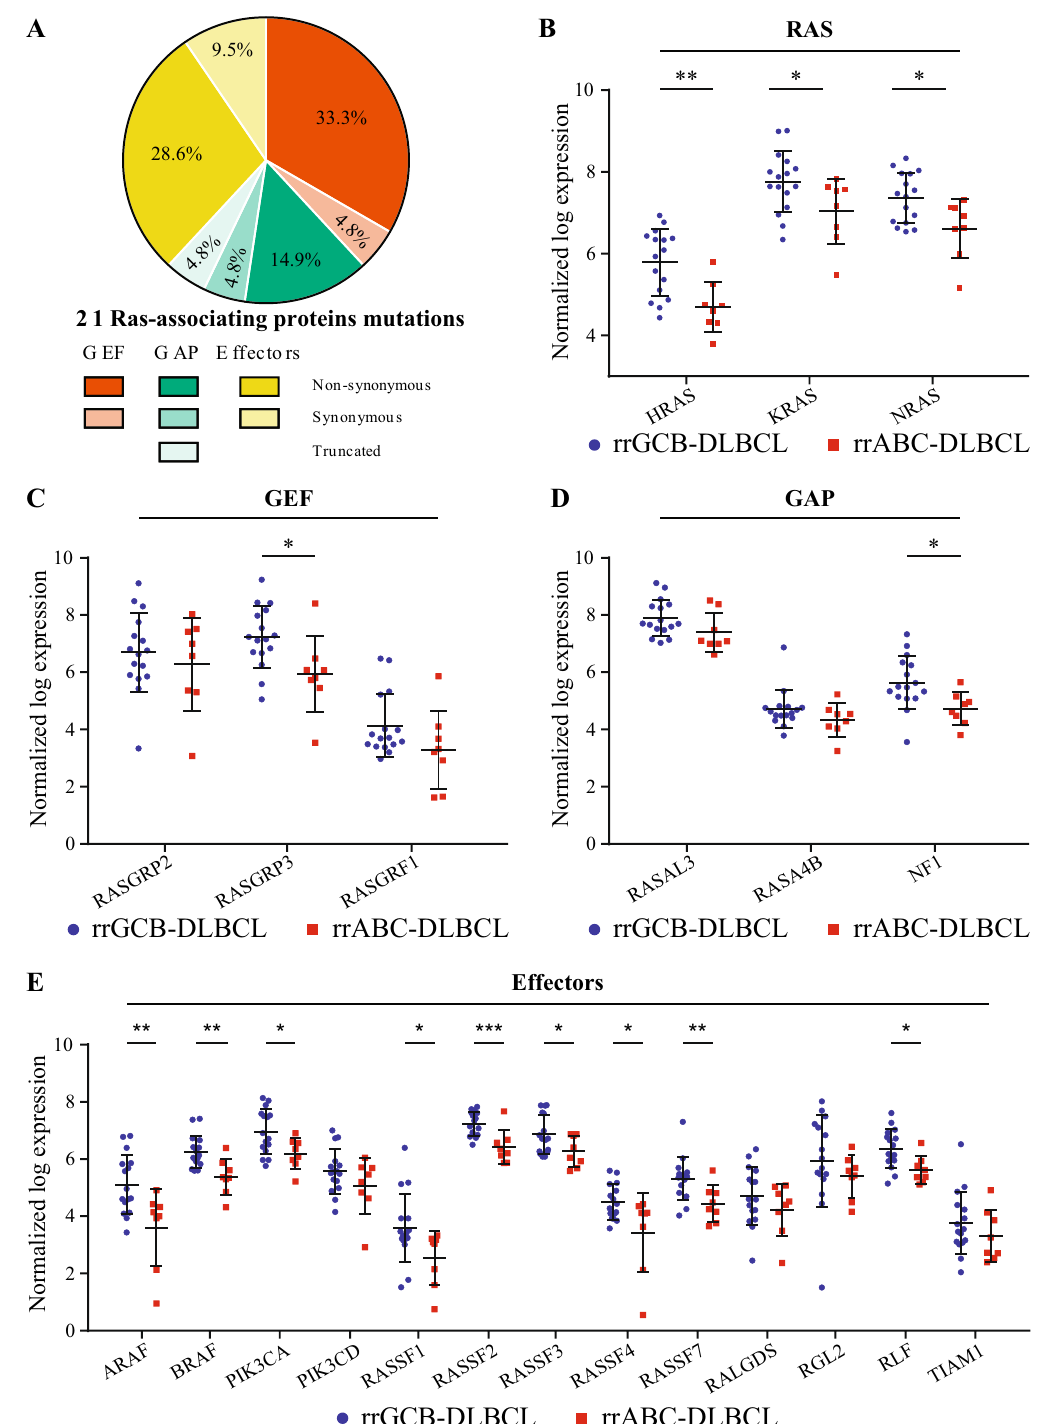
Figure 2. ( A ) Proportion of non-synonymous, synonymous and truncated mutations in each type of RAS- associating proteins. ( B ) RAS mRNA expression level is higher in rrGCB-DLBCL samples compared to rrABC- DLBCL samples. GEF ( C ), GAP ( D ), and Effector ( E ) mRNA expression level is higher in rrGCB-DLBCL samples compared to rrABC-DLBCL samples. (unpaired t-test; * = p < 0.05, ** = p < 0.01, *** = p <